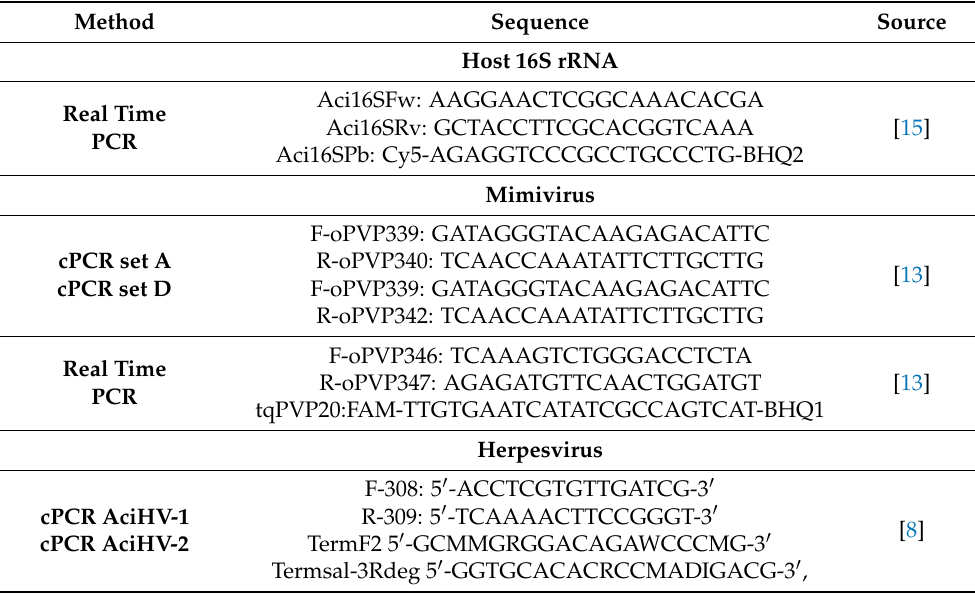
Table 1. Sequences of the oligonucleotides and probes used in this